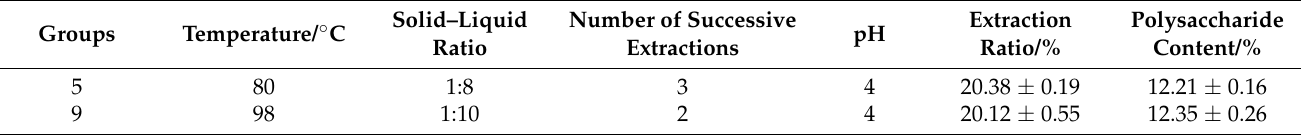
Table 2. Validation experiments of extraction conditions of group 5 and 9.